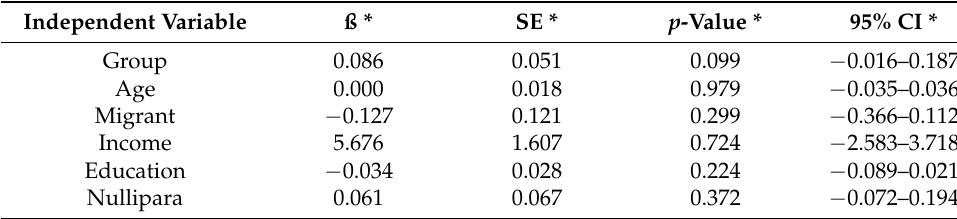
Table 2. Multiple regression analysis using GEE (dependent variable: ∆ BHLS, n = 1010).